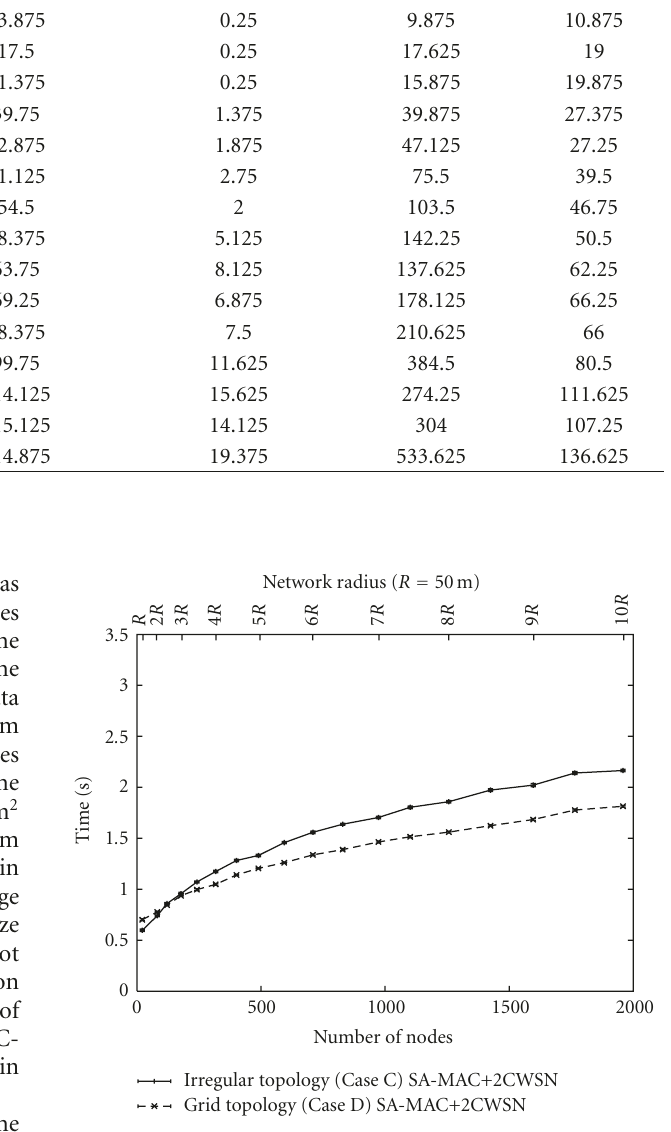
Figure 4: Network configuration times for Cases C and